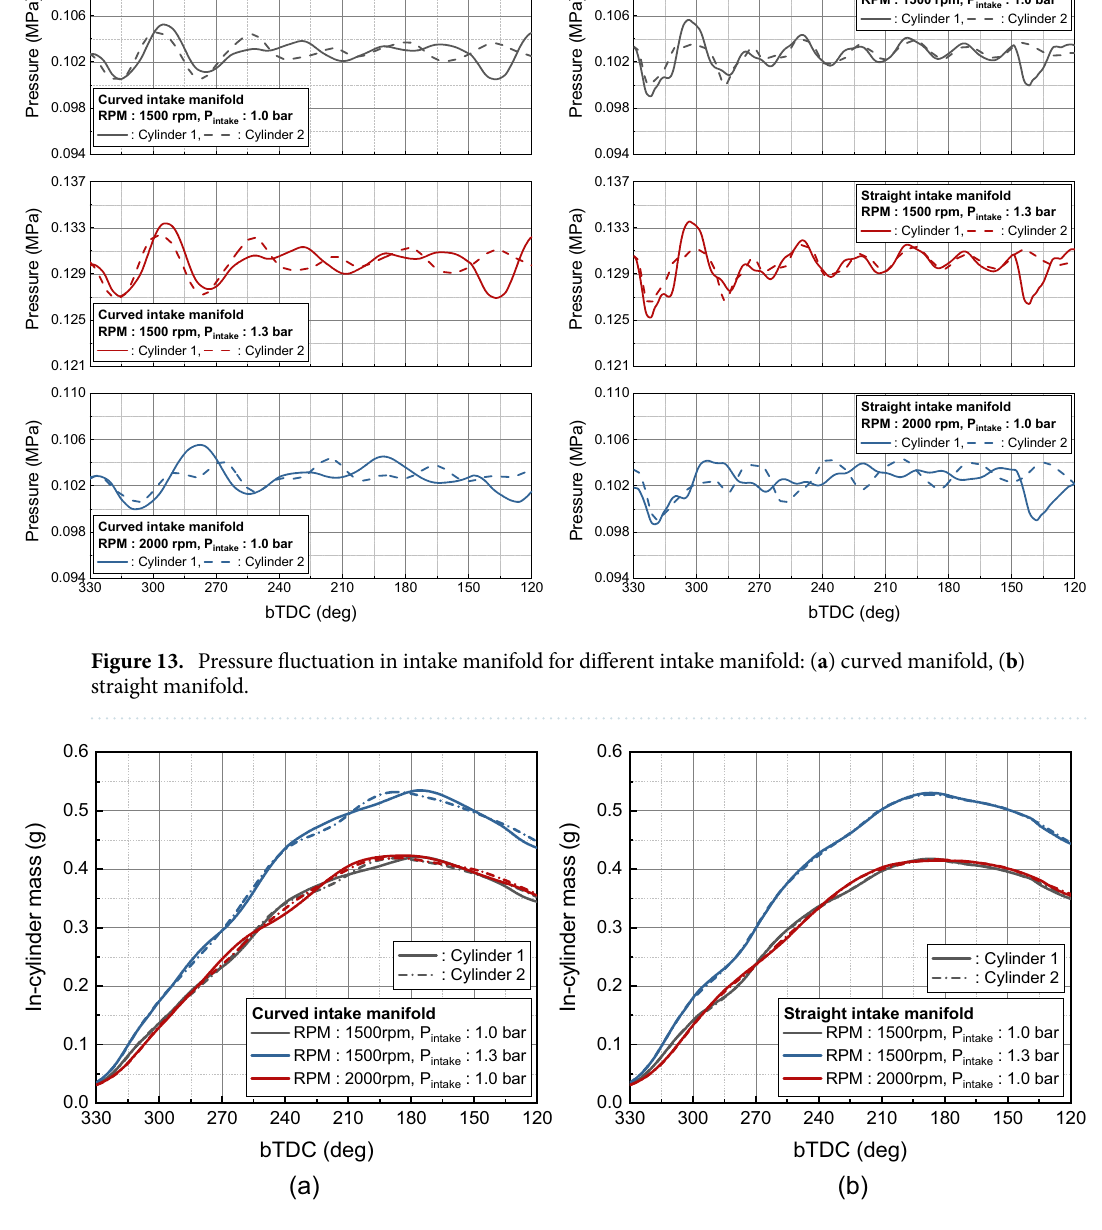
Figure 14. In-cylinder charged mass of each cylinders: ( a ) curved intake manifold, ( b ) straight intake